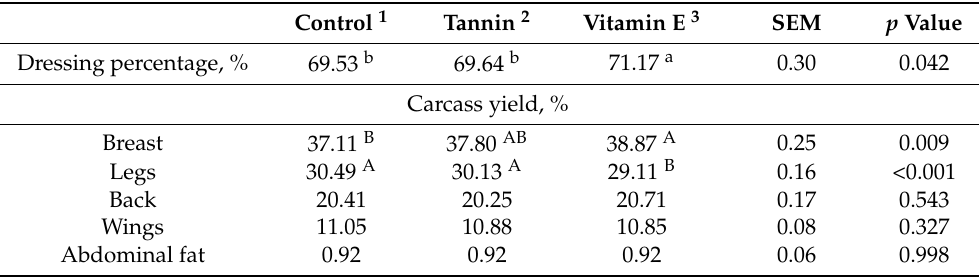
Table 3. Effect of chestnut tannins and vitamin E on the dressing percentage (ready to cook) and carcass yields (%) of breast, legs, wings, back, and abdominal fat. Control 1 Tannin 2 Vitamin E 3 SEM p Value Dressing percentage,